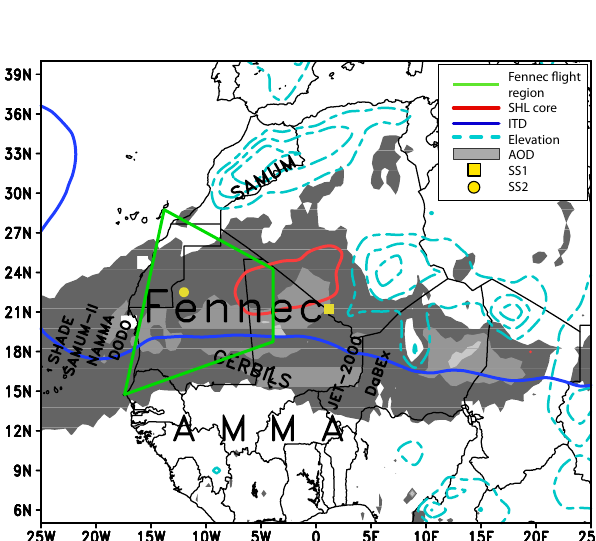
Figure 1. The Fennec domain and climatology. The figure shows mean (2000–2012) June–September aerosol optical depth (AOD) from Multi-angle Imaging SpectroRadiometer (MISR) satellite data (shaded, contour intervals are 0.4, 0.6 and 0.8) and key mean June– September circulation features derived from ERA-Interim reanaly- sis data (1979–2012), specifically the mean position of the Saha- ran heat low core (1008hPa contour of sea level pressure, thick red contour); the mean position of the inter-tropical discontinuity (solid blue line, as defined by the 10gkg − 1 contour of 925hPa specific humidity). The figure also highlights the location of the two Fennec supersites (SS1 yellow square, SS2 yellow circle), and approximate aircraft flight zone (green polygon). Also indicated are surface ele- vation (dashed cyan contours, 1000, 1500 and 2000m) and the ap- proximate location of recent airborne field